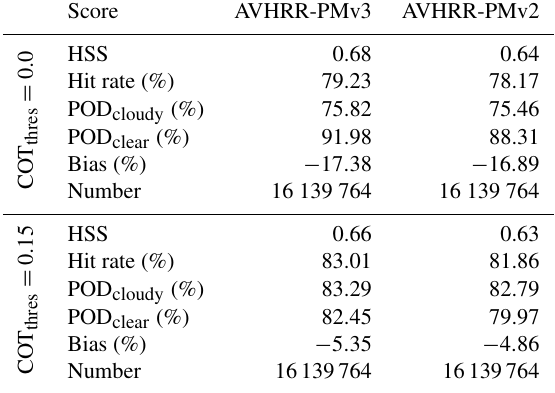
Table 2. Cloud mask (CMA) validation results for Cloud_cci AVHRR-PMv3 when compared with CALIOP. Validation results for AVHRR-PMv2 are also reported. Validation measures are Hei- dke skill score (HSS), hit rate, the probabilities of detecting cloudy and clear scenes (POD cloudy and POD clear ), and bias. In addition, the number of collocated pixels is given. The scores are separated into two cloud optical thickness thresholds (COT thres ) reflecting the CALIOP COT above which the CALIOP pixel was classified cloudy.